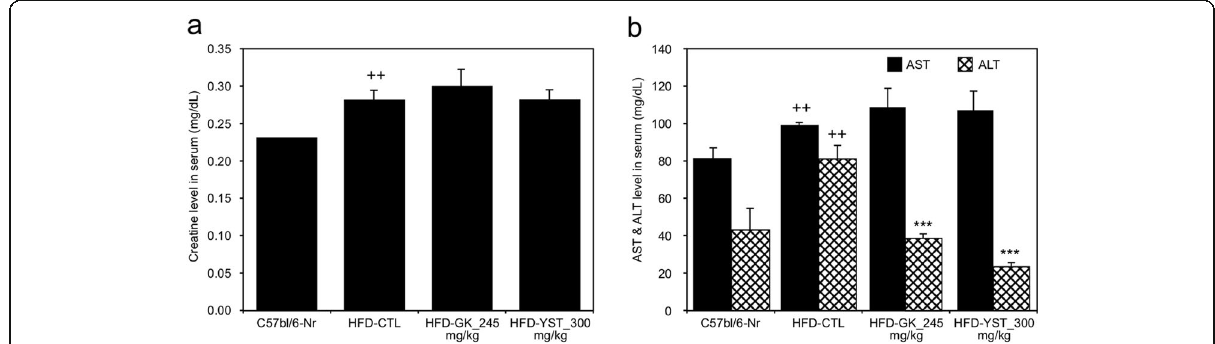
Fig. 2 Effects of YST extract on the serum parameters in high-fat diet (HFD)-fed mice. a Creatinine, b aspartate transaminase (AST) and alanine transaminase (ALT). Normal diet group: C57bl/6 J-Nr; HFD-control group: HFD-CTL; HFD plus 245 mg/kg Garcinia cambogia extract: HFD-GK; HFD plus 300 mg/kg YST: HFD-YST. The results are expressed as mean ± SEM ( n = 6). + p < 0.05, ++ p < 0.01, and +++ p < 0.001 compared with C57bl/6 J-Nr, and * p < 0.05, ** p < 0.01, and *** p < 0.001 compared with